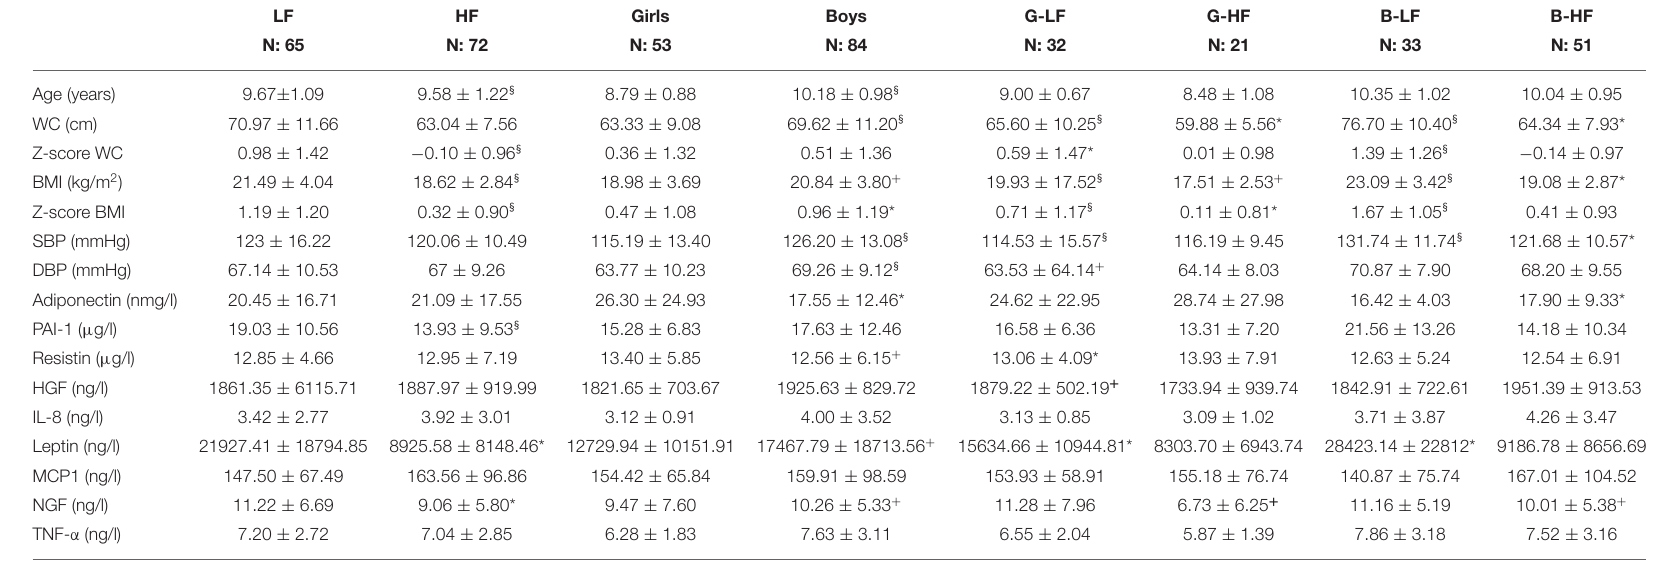
TABLE 1 | Anthropometric and demographic variables as well as concentration of plasma adipokines and inflammatory cytokines classified by grouped by fitness levels and gender. LF HF